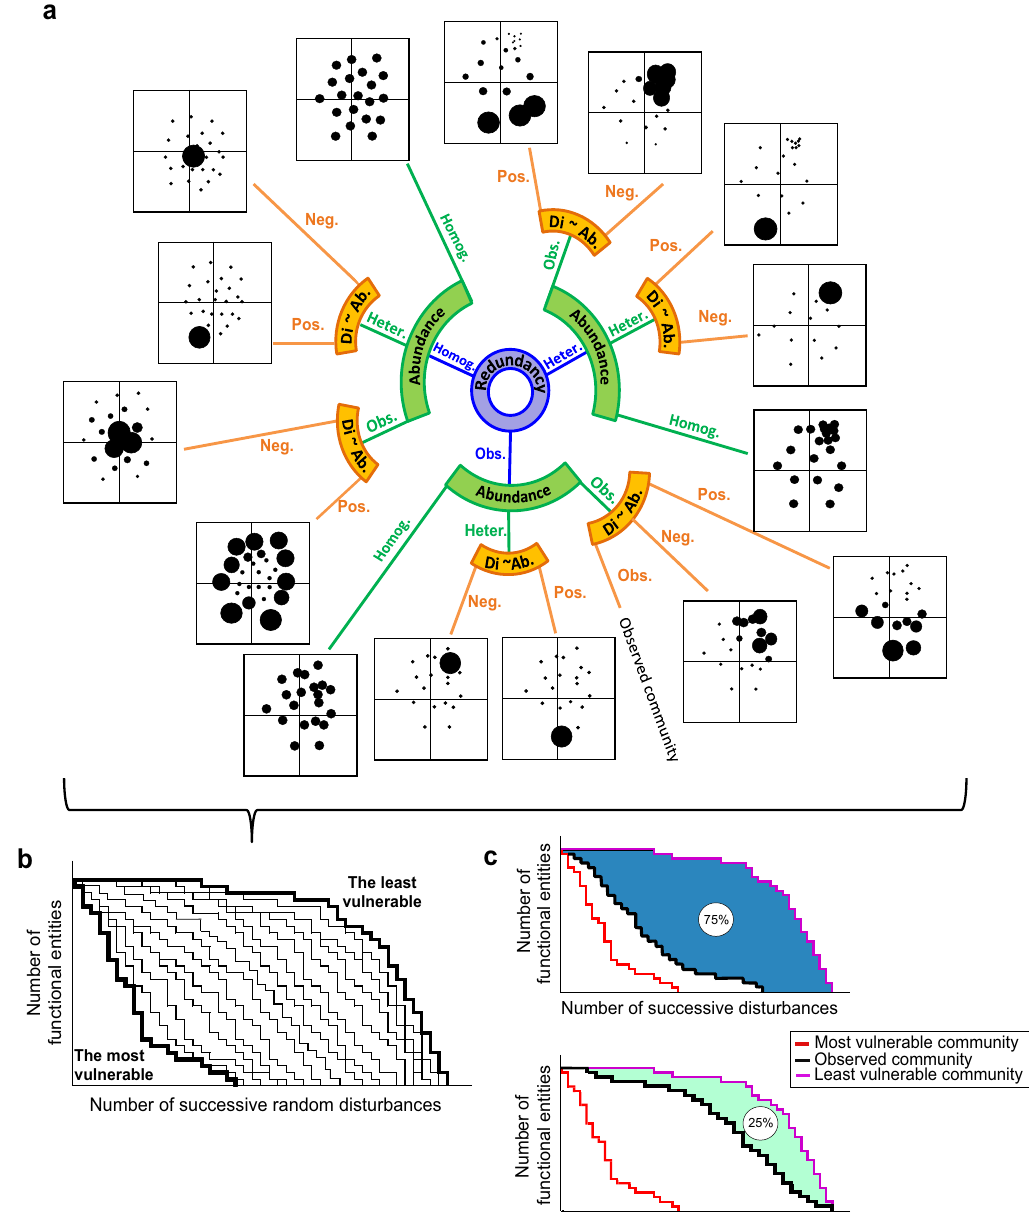
Fig. 1 | Conceptual representation of the functional vulnerability framework. a The varioustraitspacescorrespond to the virtualcommunitiescreatedfromthe observed target community. The size of each dot (i.e., species) is proportional to abundance (Ab.). The blue circle separates virtual communities into three main categoriesaccording tothe distribution offunctionalredundancy: heterogeneous (Heter.), homogeneous (Homog.), observed (Obs.). The green and orange circle segments subdivide the virtual communities according to the distribution of species ’ abundance (heterogeneous, homogeneous, observed) and the positive (Pos.)ornegative(Neg.)signoftherelationshipbetweenfunctionaldistinctiveness